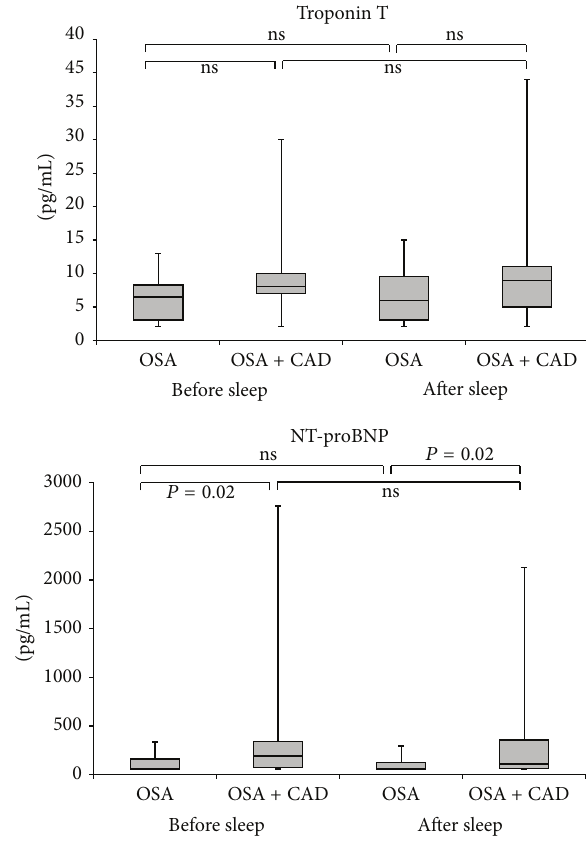
Before sleep After sleep Figure 2: Distribution of troponin T and NT-proBNP levels before and after sleep (CAD: coronary artery disease; OSA: obstructive sleep apnea). Middle horizontal line inside box indicates median. Bottom and top of the box are 25th and 75th percentiles, and the error bars outside the box represent maximum and minimum values,